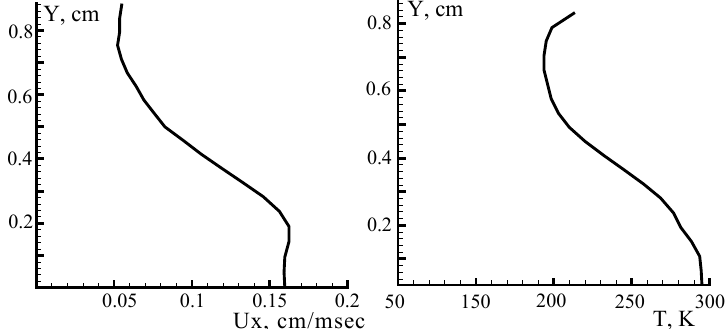
u (a) and temperature T (b) across the compacted region of the x